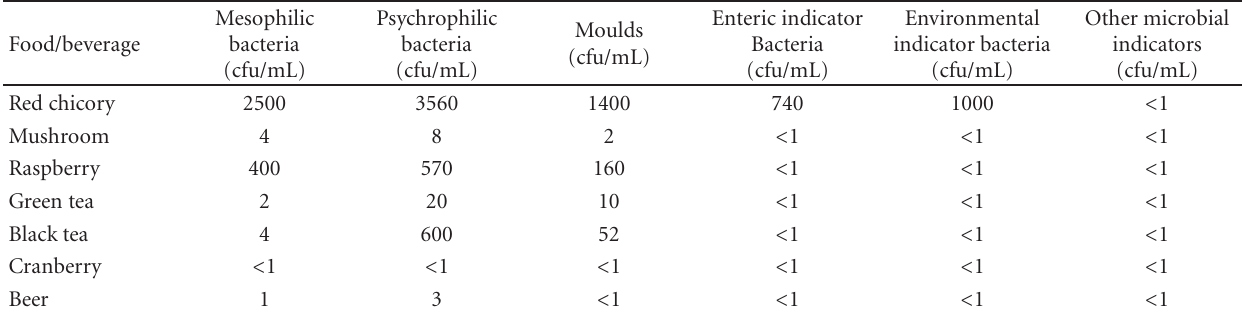
Table 4: Microbial contamination of selected food/beverages.